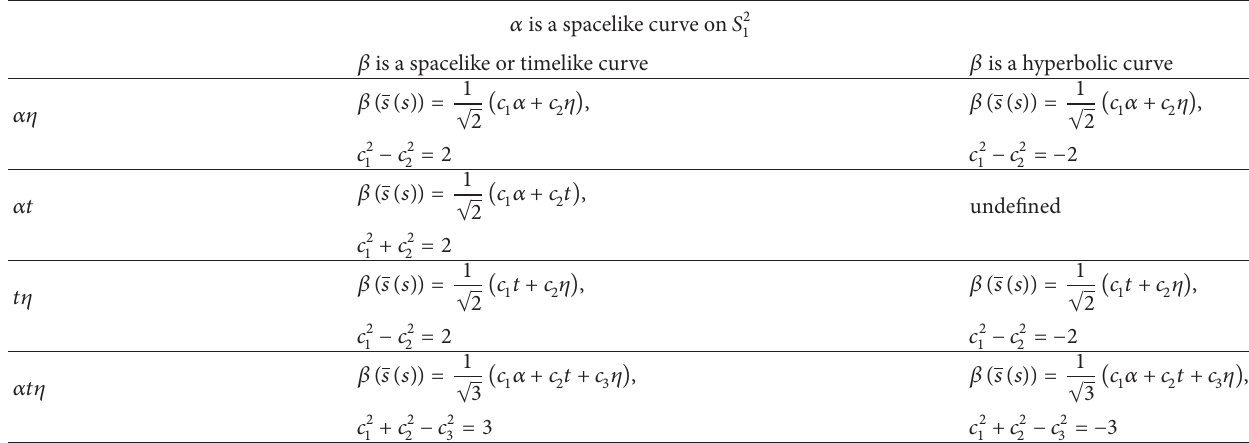
Table 1: Classification of the Smarandache curves for spacelike curve 𝛼 . 𝛼 is a spacelike curve on 𝑆 2